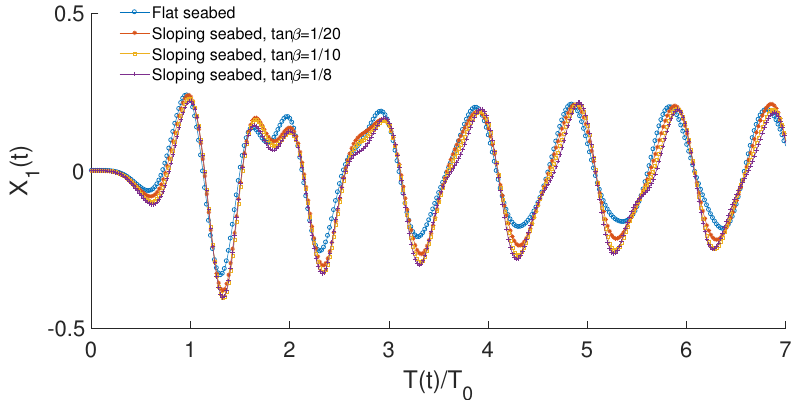
Figure 19. Comparison of time record of floating body surge motion X 1 ( t ) for wave frequency kd = 1.0 between flat seabed, sloping seabed with tan θ = 1/20, tan θ = 1/10 and tan θ = 1/8,